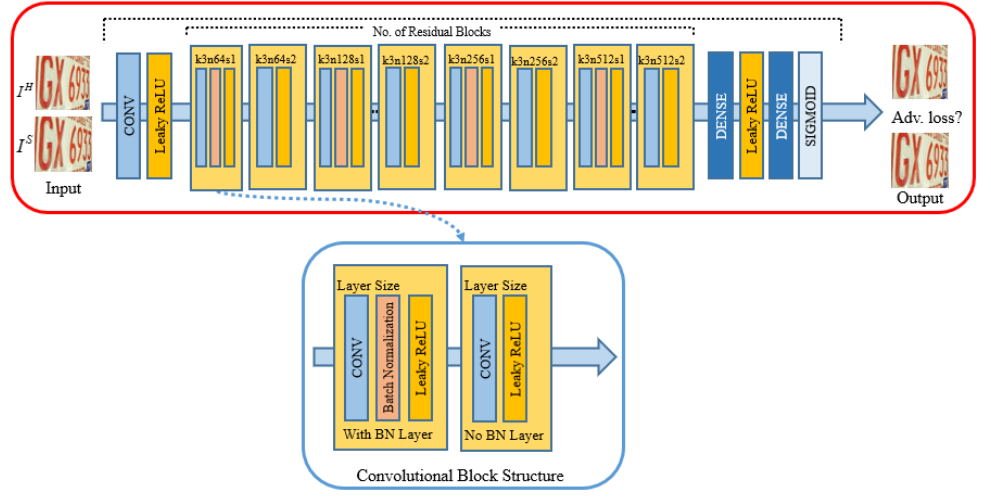
Figure 3. Architecture of the discriminator network. “k” represents filter size, “n” is the number of fil‑ ters, and “s” is the stride value used in a particular layer. Two types of convolutional blocks are used in the discriminator. One type of convolutional block comprises a convolution, batch normalization, and leaky ReLU layers. The other type of convolutional block lacks the batch normalization layer. Equation (5) is used to calculate the adversarial loss in terms of the probabilities re‑ turned by D . This adversarial loss is then combined with another loss to obtain the final objective function of